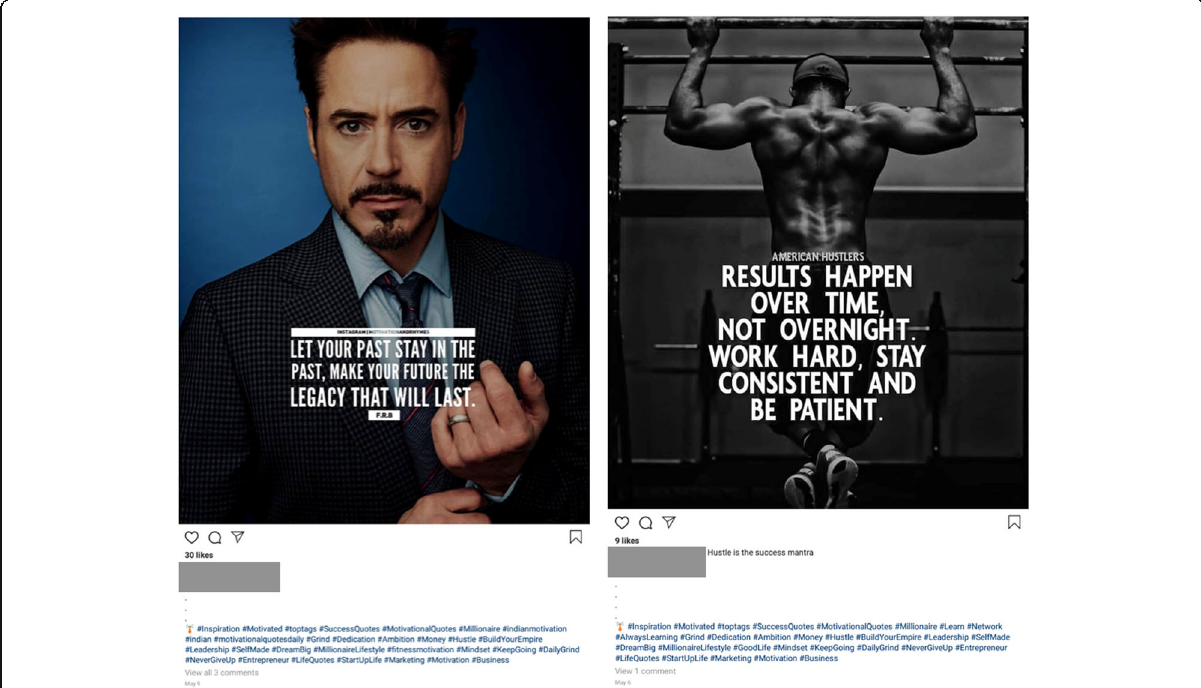
Fig. 2 Two posts illustrating the good life narrative of the self-made affluent